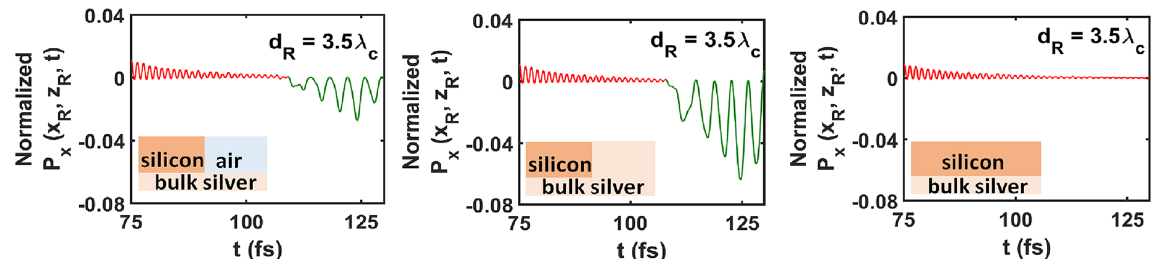
λ = ; λ = . d 3 5 when 1200 nm ;  is occupied by c C x R R R c is occupied by silver. Each profile is of the tail of the D x R R